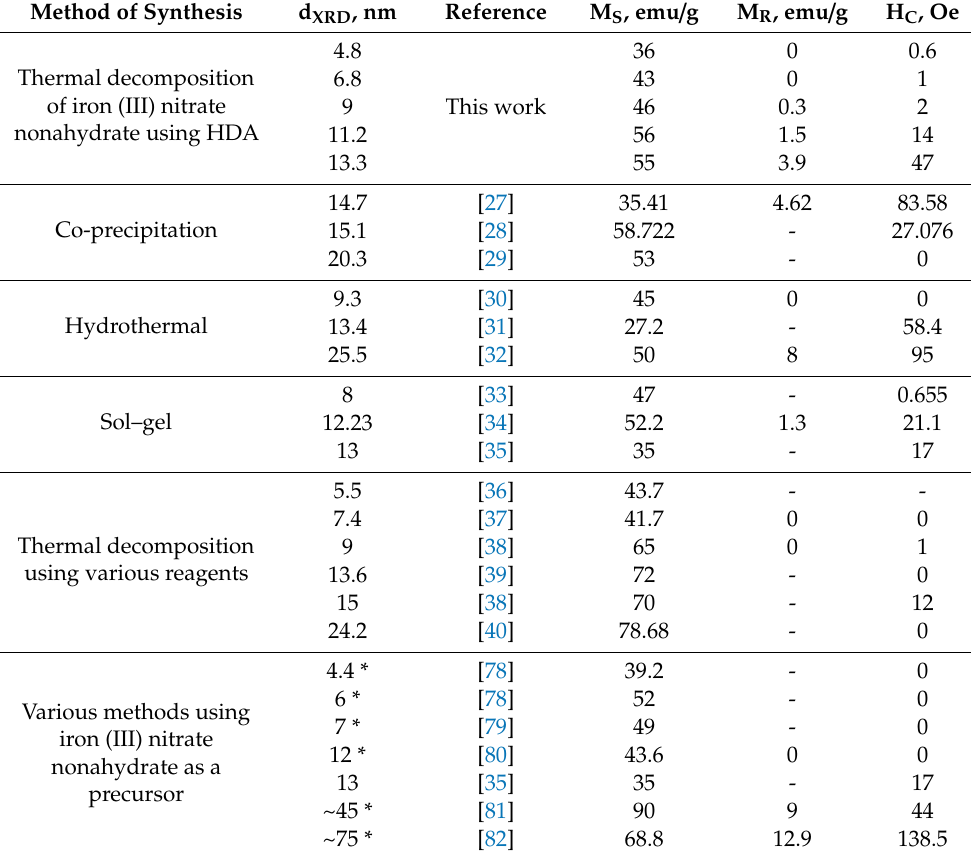
Table 2. Comparison of magnetic properties at room temperature and sizes of magnetite nanoparticles synthesized by various